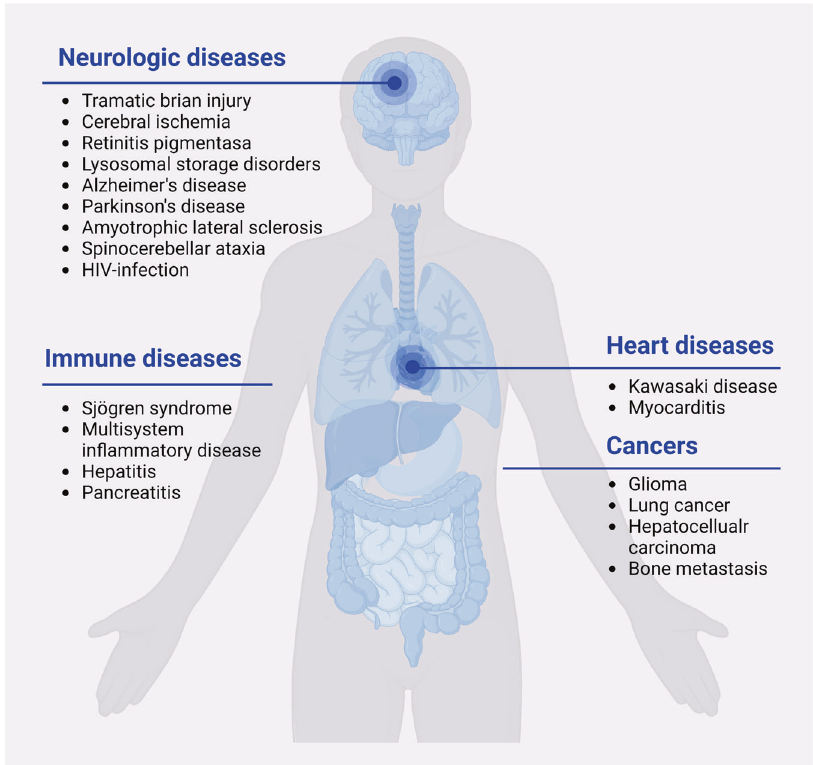
Fig. 7 Cathepsin B in diseases. Schematic representation of CatB-mediated cell death in neurologic diseases, immune diseases, cardiac diseases and